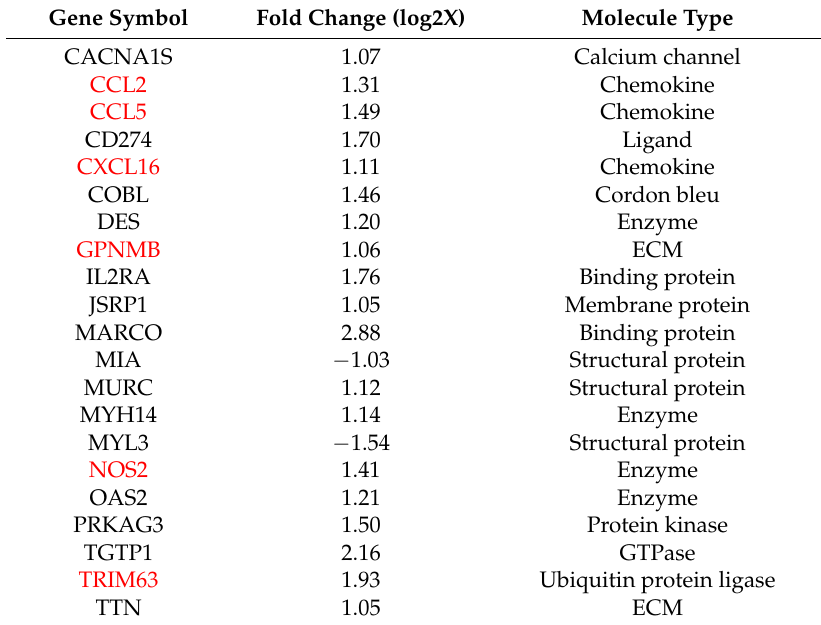
Table 2. 21 target genes of Hypoxia-inducible factor 1 α (HIF-1 α ) out of 216 DEGs in diabetic mice through TRANSFAC ®